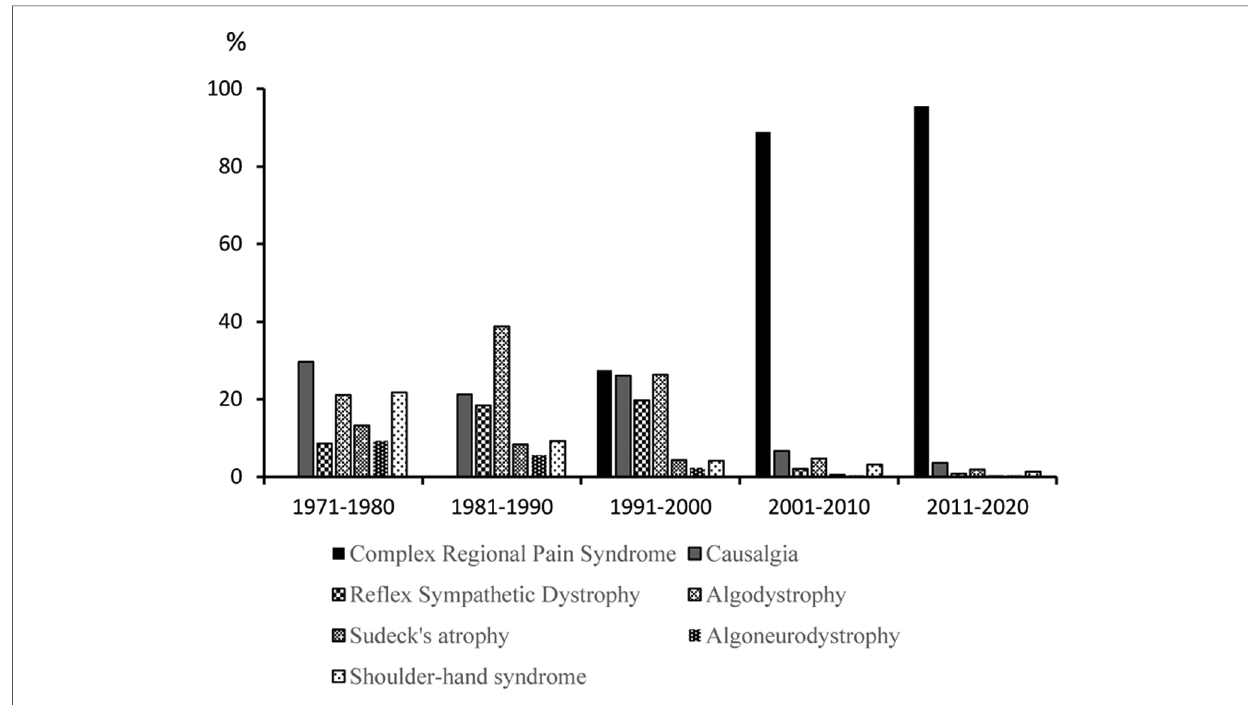
FIGURE 1 Evolution of the number of complex regional pain syndrome publications in PubMed from 1971 to 2020. The seven keywords/keyphrases were searched in the Title/Abstract fi elds and shown in fi ve 10-year periods (1971 – 1980, 1981 – 1990, … ), each period totaling 100% of